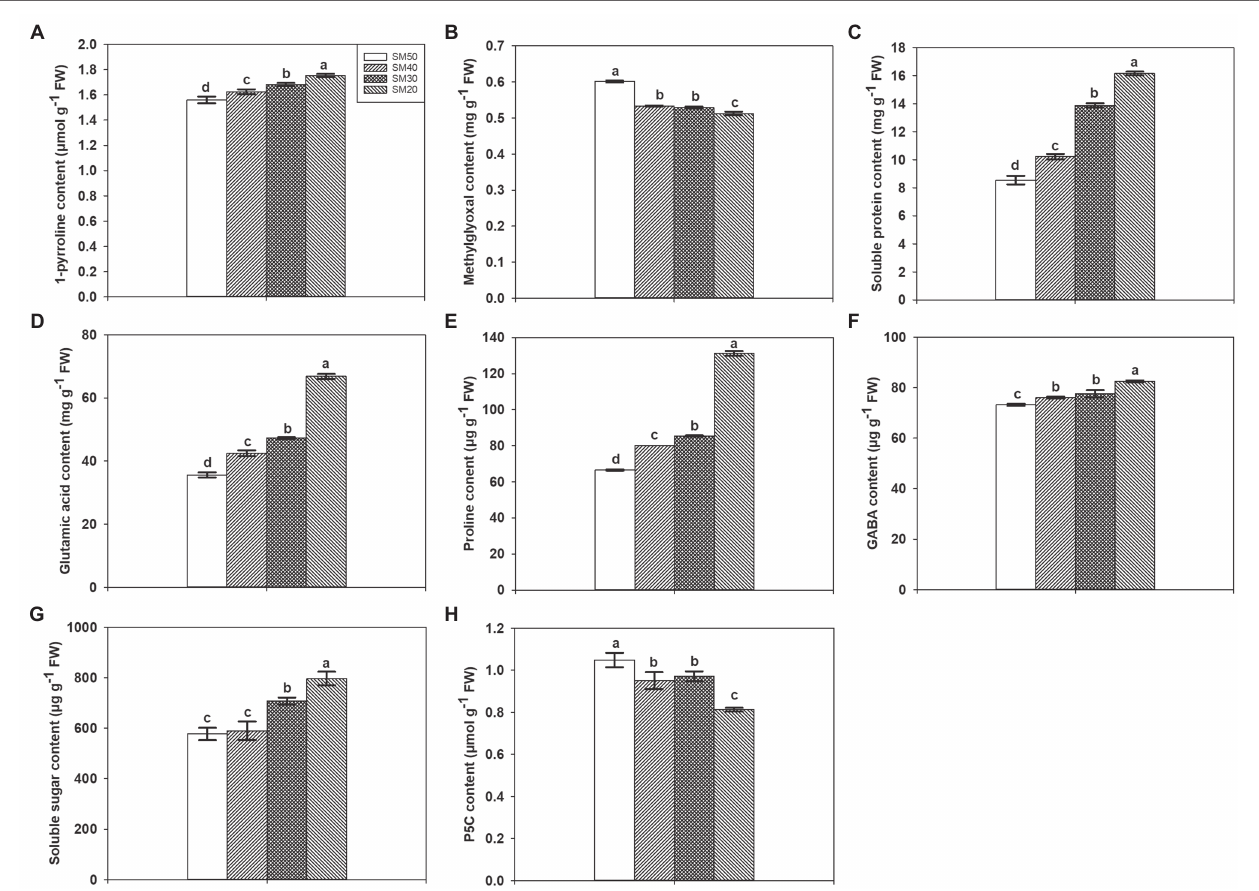
FIGURE 3 | Effects of different soil moisture contents on 1-pyrroline (A) , methylglyoxal (B) , soluble protein (C) , glutamic acid (D) , proline (E) , GABA (F) , soluble sugar (G) , and P5C (H) contents in fragrant rice. Each column represents the mean of three data ± standard error ( n = 3). Bars sharing a common letter do not differ significantly at ( p <